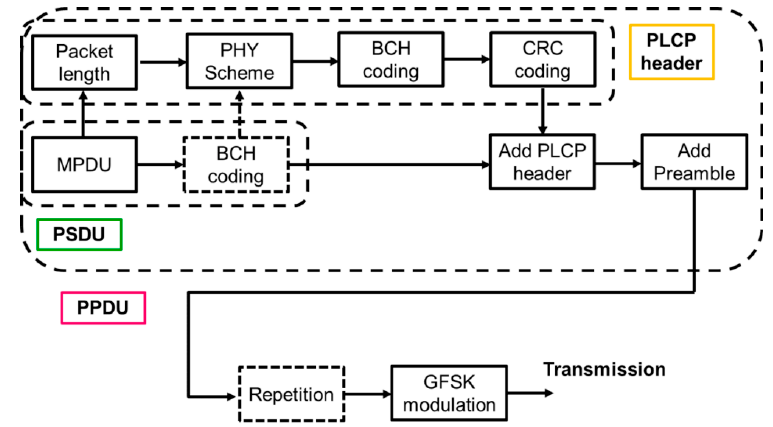
Figure 7. Block diagram of PHY receiver.